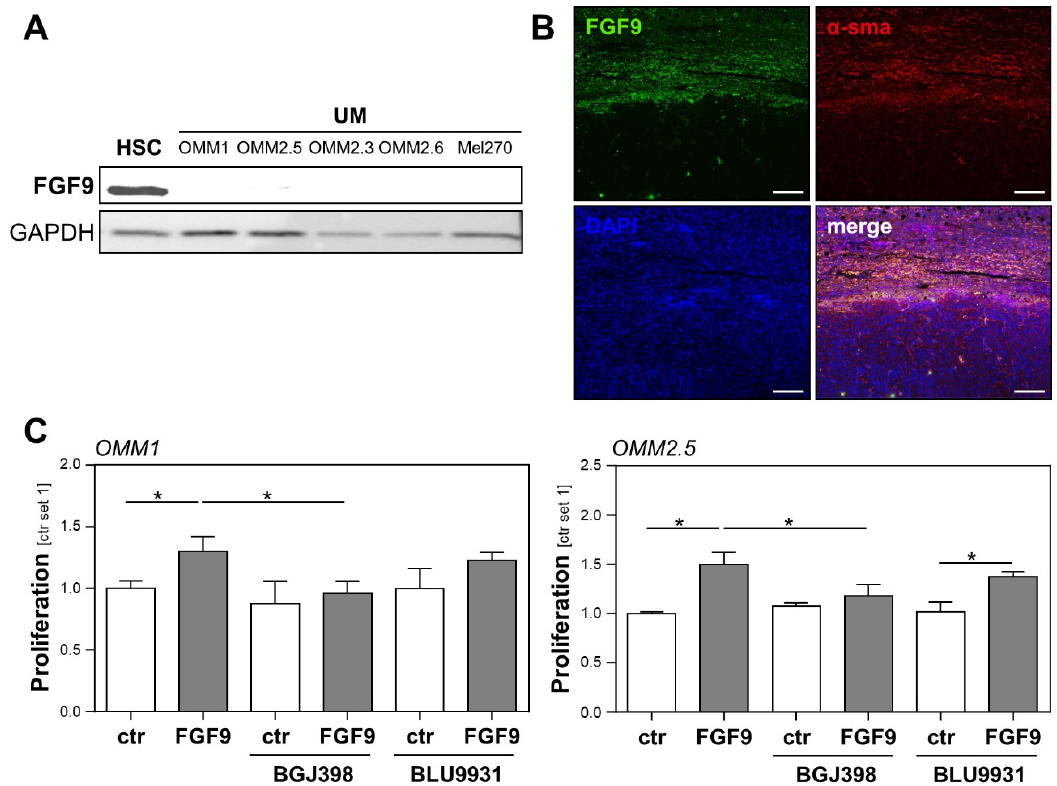
Figure 4. Expression of FGF9 in hepatic metastasis from uveal melanoma (UM) and the effect of FGF9 on the tumorigenicity of UM cells. ( A ) FGF9 protein expression (analyzed by Western blot) in primary human hepatic stellate cells (HSC) and human UM cell lines (OMM1, OMM2.5, OMM2.3, OMM2.6, and Mel270). ( B ) Immunofluorescence staining for FGF9 (green) and alpha-smooth muscle actin ( α -sma, red) in human liver metastasis from UM. Nuclei were counterstained using DAPI (blue; scale bar: 200 µ m). ( C ) Effects of BGJ398 (FGFR1/2/3 inhibitor, 100 nM) and BLU9931 (FGFR4 inhibitor, 100 nM) on the FGF9-induced proliferation of OMM1 (left panel) and OMM2.5 (right panel) cells. Proliferation was assessed 48 h after the stimulation of cells (*: p < 0.05).